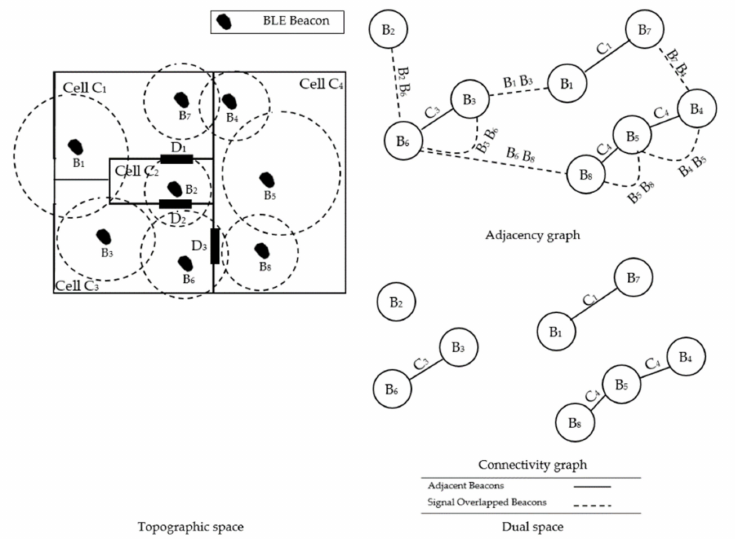
Figure 5. Extracting adjacency and connectivity graph for BLE beacons from two-dimensional topologic indoor